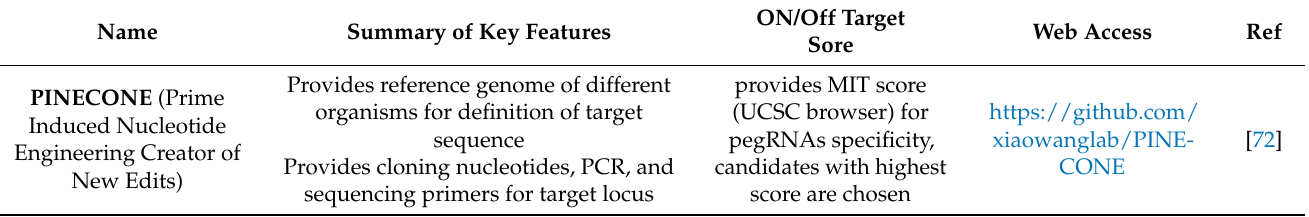
Table 2. In silico tools for pegRNA